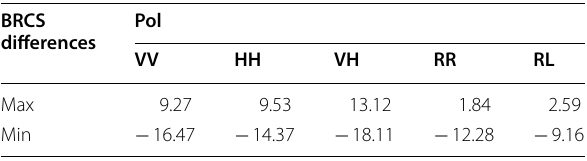
Table 2 Maximum